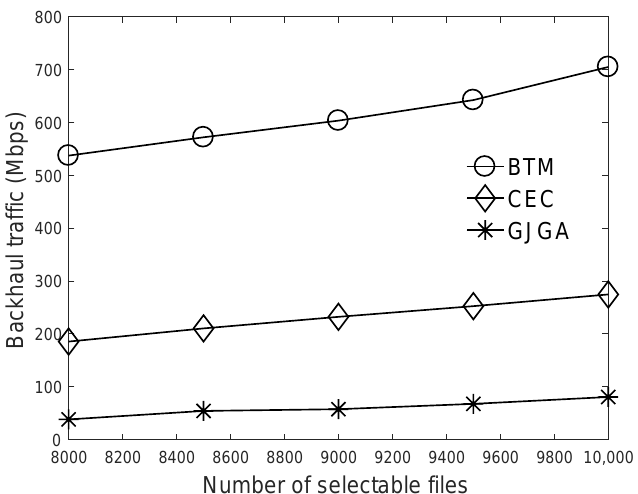
Figure 7. Effects of the number of selectable files on the total backhaul traffic under 600 UEs and the cache size of